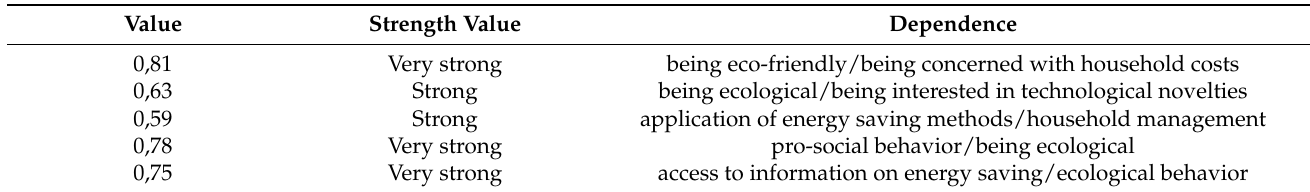
Table 4. Relationship analysis—Pearson’s C index.